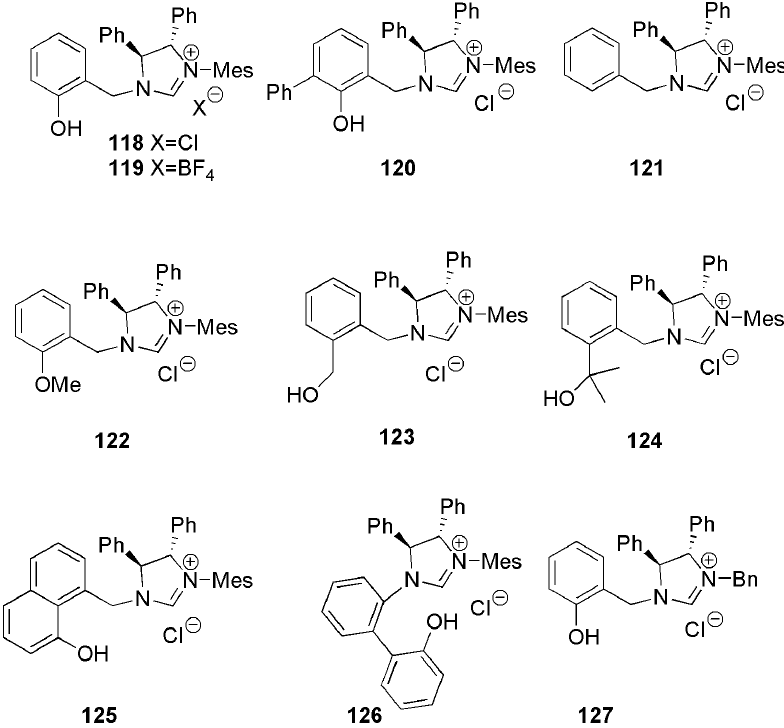
Figure 10. Structure of a magnesium NHC ‐ phenoxy chelate [154]. Figure 9. Chiral bidentate NHC ‐ hydroxy ligands [154]. Figure 9. Chiral bidentate NHC-hydroxy ligands [154].